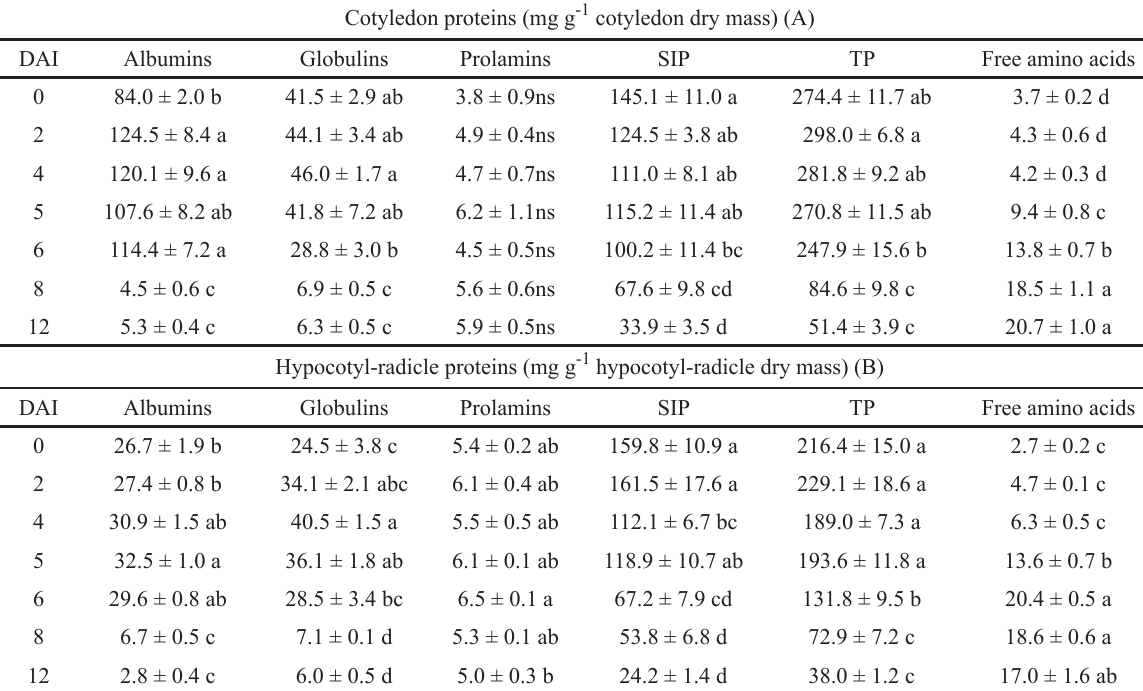
Changes in albumin, globulin, prolamin, salt insoluble protein (SIP), free amino acids (FAA) and total protein (TP) contents in Cereus jamacaru seed cotyledons (A) and hypocotyl-radicle axis (B). The total protein (TP) corresponds to the sum of albumins, globulins, prolamins and